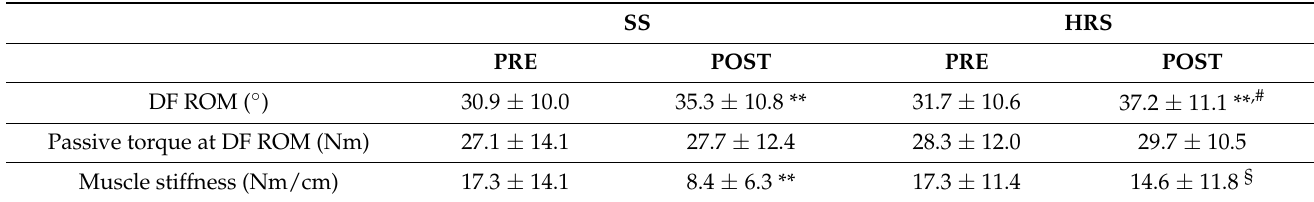
Table 1. Changes in variables before and after stretching interventions.